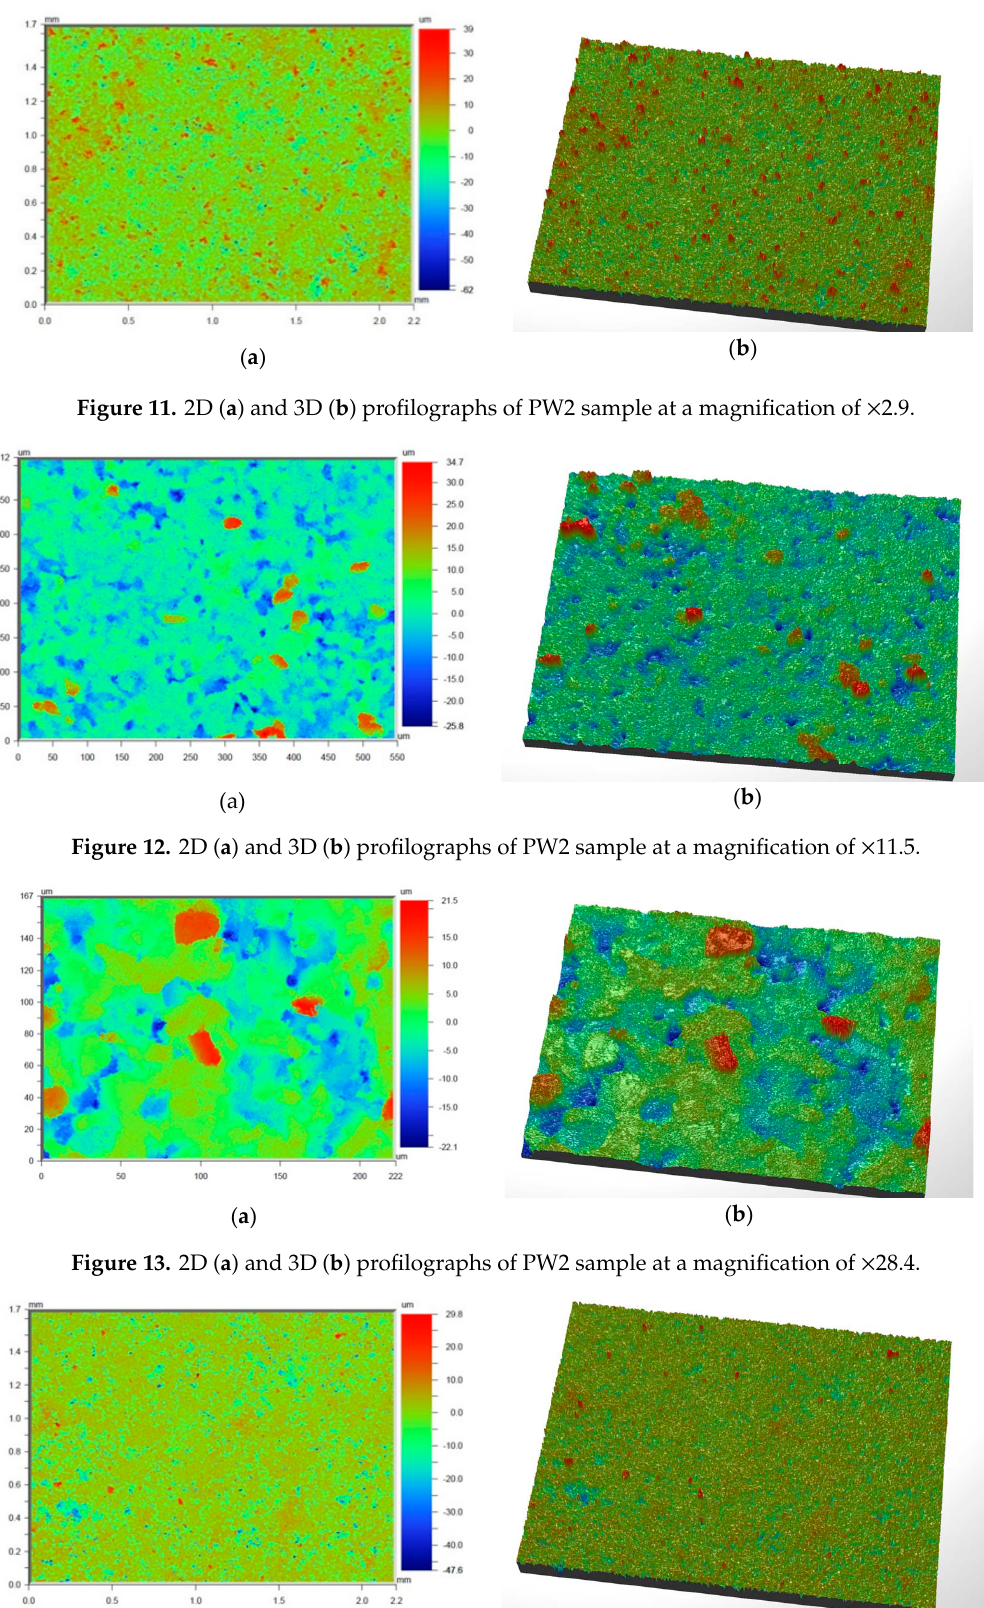
( b ) Figure 15. 2D ( a ) and 3D ( b ) profilographs of PW3 sample at a magnification of ×11.5. ( a ) ( b ) Figure 16. 2D ( a ) and 3D ( b ) profilographs of PW3 sample at a magnification of ×28.4. Figures 17–19 show tomograms of the fractures of PW1, PW2, and PW3 sample shell molds. The images show that the binder coated the SiC F400 and SiC F40 and F80 particles in individual shell mold layers. After dewaxing, PW1 contained pores and individual fractures in its outer structural layers. As a result, a compact material with a relatively low number of defects was obtained (Figure 17). Burnout preheating at 700 °C/1 h increased both the number and diameter of pores in the material (Figure 18). Further burnout preheating of the materials at 1200 °C/1 h formed macroscopic discontinuities in the penultimate layer and generated Al 2 O 3 nanoparticles at the edges of sprinkling grains. Upon increasing the preheating temperature, a growing number of pores was generated with a stochastic distribution (Figure 17). The reasons for defect generation, in particular in the sample annealed at 1200 °C (PW3), were due to a low interaction among SiC grains and aluminum oxide nanoparticles,